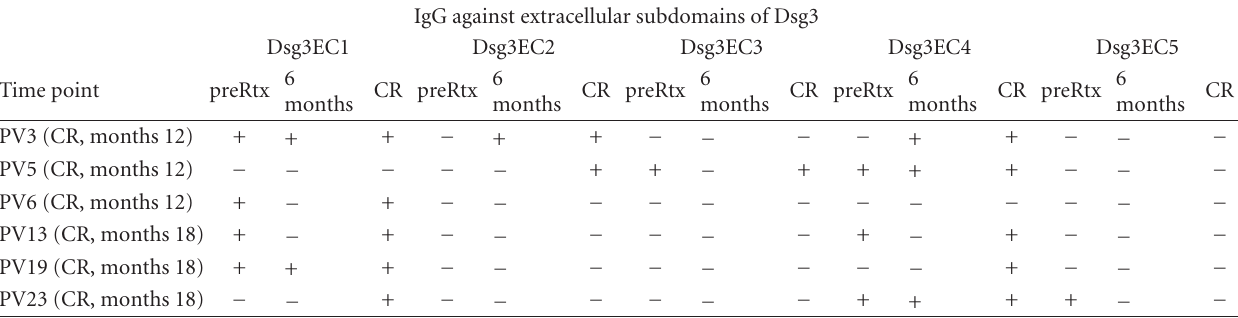
Table 3: Synopsis of the IgG autoantibody profile of the pemphigus vulgaris (PV) patients prior to rituximab (preRtx) treatment and at the time of clinical relapse (CR). IgG against extracellular subdomains of Dsg3 Dsg3EC1 Dsg3EC2